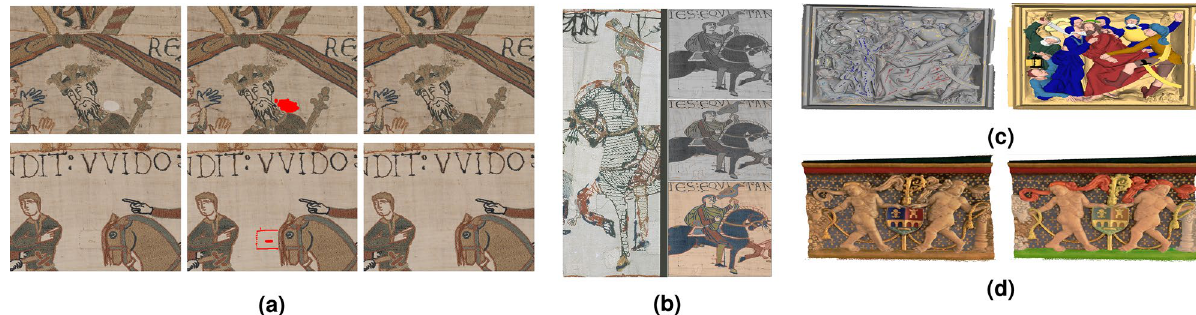
Figure 2. Virtual restoration and colorization. ( a ) 2D restoration (original images, images with areas to be restored indicated in red, and restoration results). ( b ) 2D colorization, where the left column represents the backside of a scene from the Bayeux Tapestry, and the second column represents the initial image, the image with seeds, and the colored result. ( c , d ) 3D colorization, with input models on the left and colored ones on the